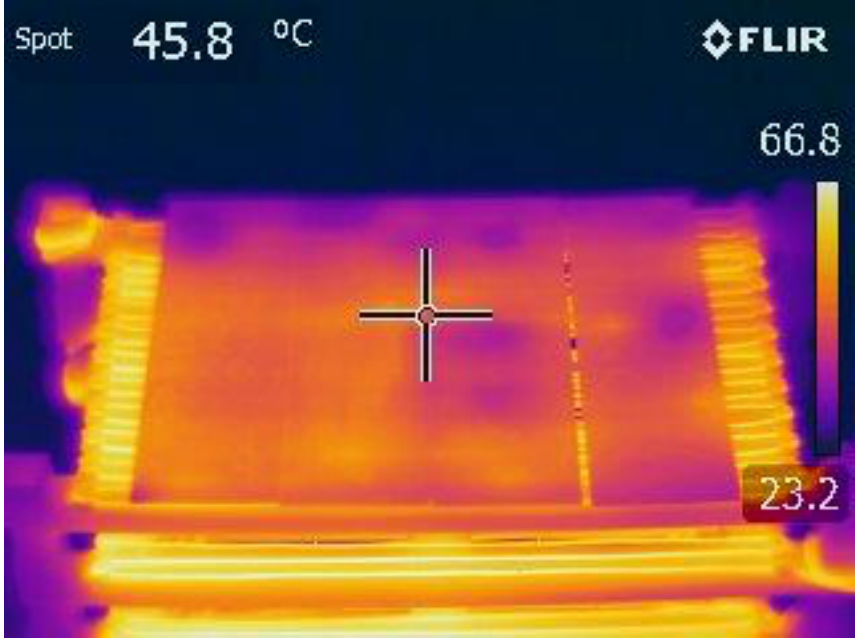
Figure 5. The thermal distribution of the wet slides while drying.